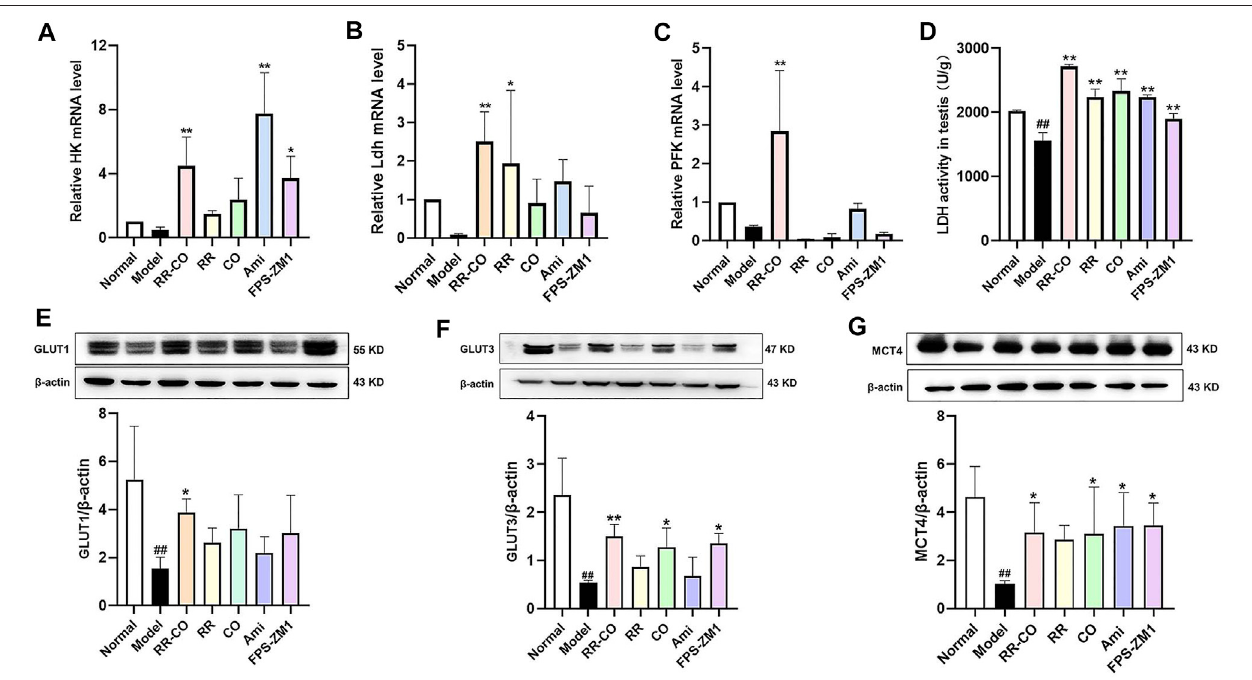
FIGURE 4 | Effects of RR-CO on the expression of the aerobic glycolysis-related enzymes and transport protein (A) Relative HK mRNA level in testis (B) Relative LDH mRNA level in testis (C) Relative PFK mRNA level in testis (D) LDH activity in testis (E) The GLUT1 protein expression in testis (F) The GLUT3 protein expression in testis (G) The MCT4 protein expression in testis. Signi fi cance: ## p < 0.01 vs. normal group; * p < 0.05, ** p < 0.01 vs. model